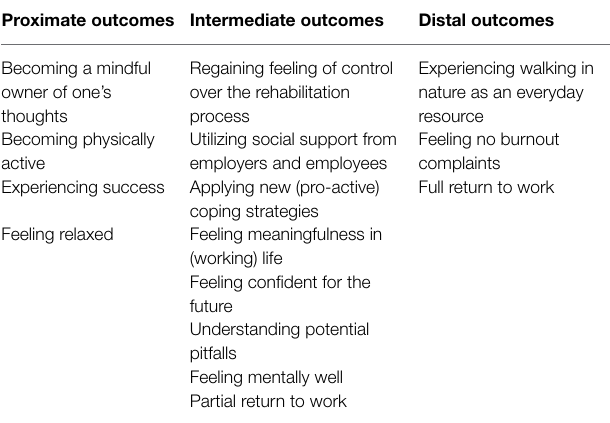
TABLE 3 | Key outcomes triggered by the implementation of the six intervention elements and change process. Proximate outcomes Intermediate